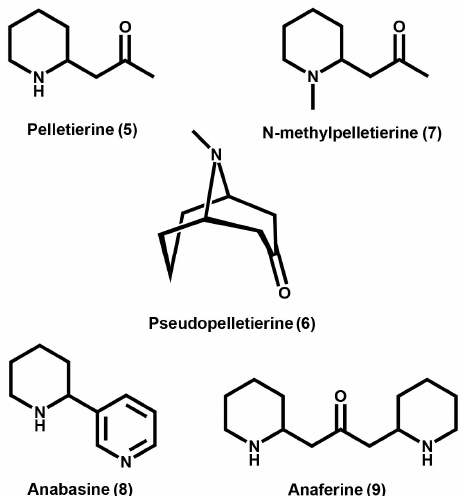
Figure 2. Examples of granatane alkaloids and granatane alkaloid derivatives found among several plant species.